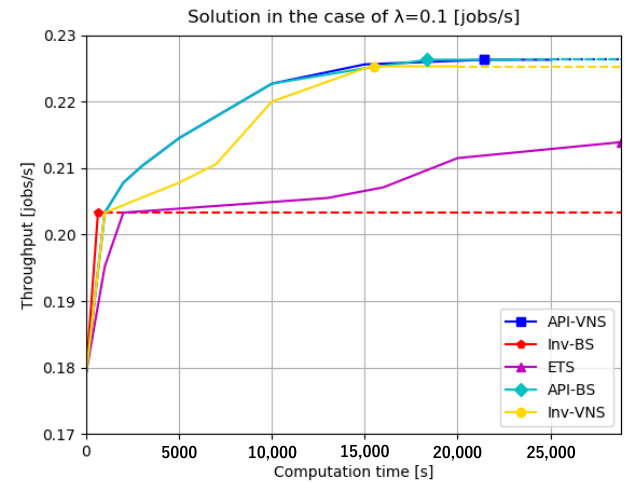
Figure 16. Computation time vs. throughput curves for the five methods in the case of λ = 0.1 in experiment 2.